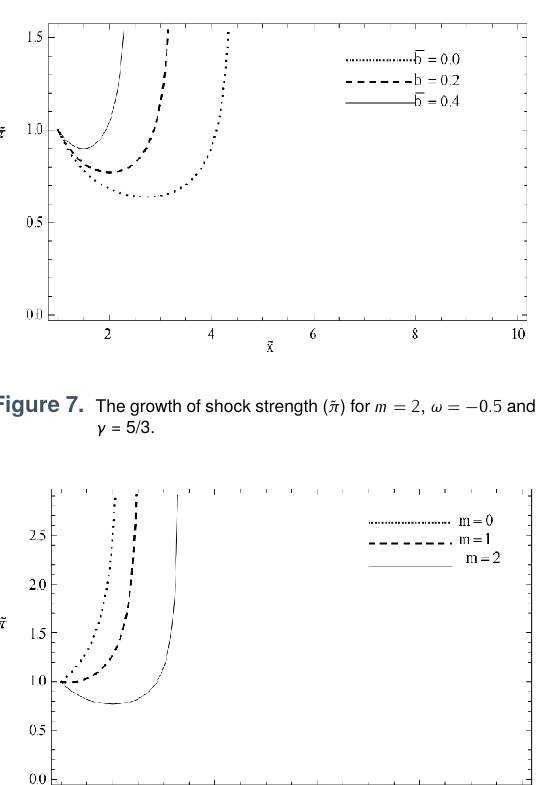
˜ π ) for ω = − 0 . 5 , ¯ b = 0 . 2